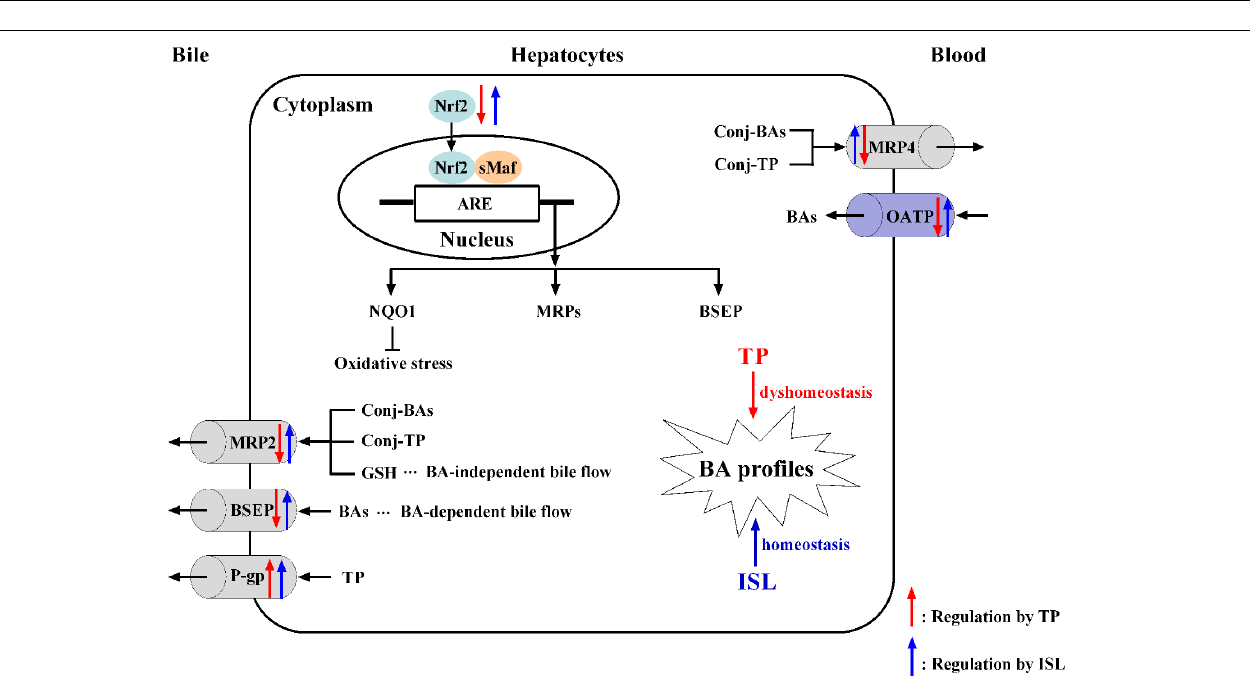
FIGURE 8 | In vitro transport assay to determine the interaction between TP and hepatic transporters. (A,B) Effects of TP on P-gp and MRP2-mediated transports in the vesicular transport (VT) assay. TP was incubated with relative membrane vesicles and substrates at 37 ◦ C for 10 min. N-methyl quinidine was used as the positive control. The ATP-dependent transport in the absence of TP was set as 100%. (C–E) Uptake of TP by MRP2 in the VT assay as well as OATP1B1 and OATP1B3 in human embryonic kidney 293 cells. Membrane vesicles or cells were incubated with TP at 37 ◦ C for 10 min. E 2 17 β G was used as the positive control. Uptake ratio (UR) in the MRP2 vesicles was calculated by the transport activity in the presence of ATP dividing that in the presence of AMP. UR in the OATP-expressing cells was calculated by the transport activity in OATP-expressing cells dividing that in the control cells. Data were presented as means ± SE ( n = 3).